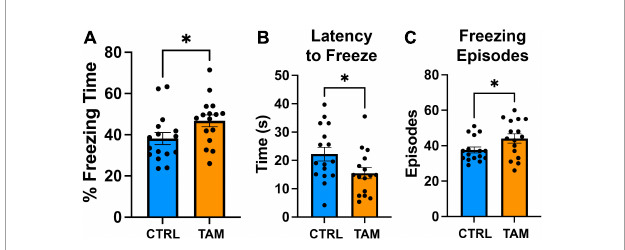
FIGURE6 Tamoxifen increases contextual fear response. Blue bars show results from control mice (CTRL); orange bars show tamoxifen-treated mice (TAM). (A) Percent time spent freezing in the conditioned environment 48 h post-training without shock. (B) Latency to freeze in the conditioned environment 48 h post-training without shock. (C) Number of freezing episodes in the conditioned environment 48 h post-training without shock. N = 16 mice per group; mean ± standard error. ∗ p < 0.05, unpaired t